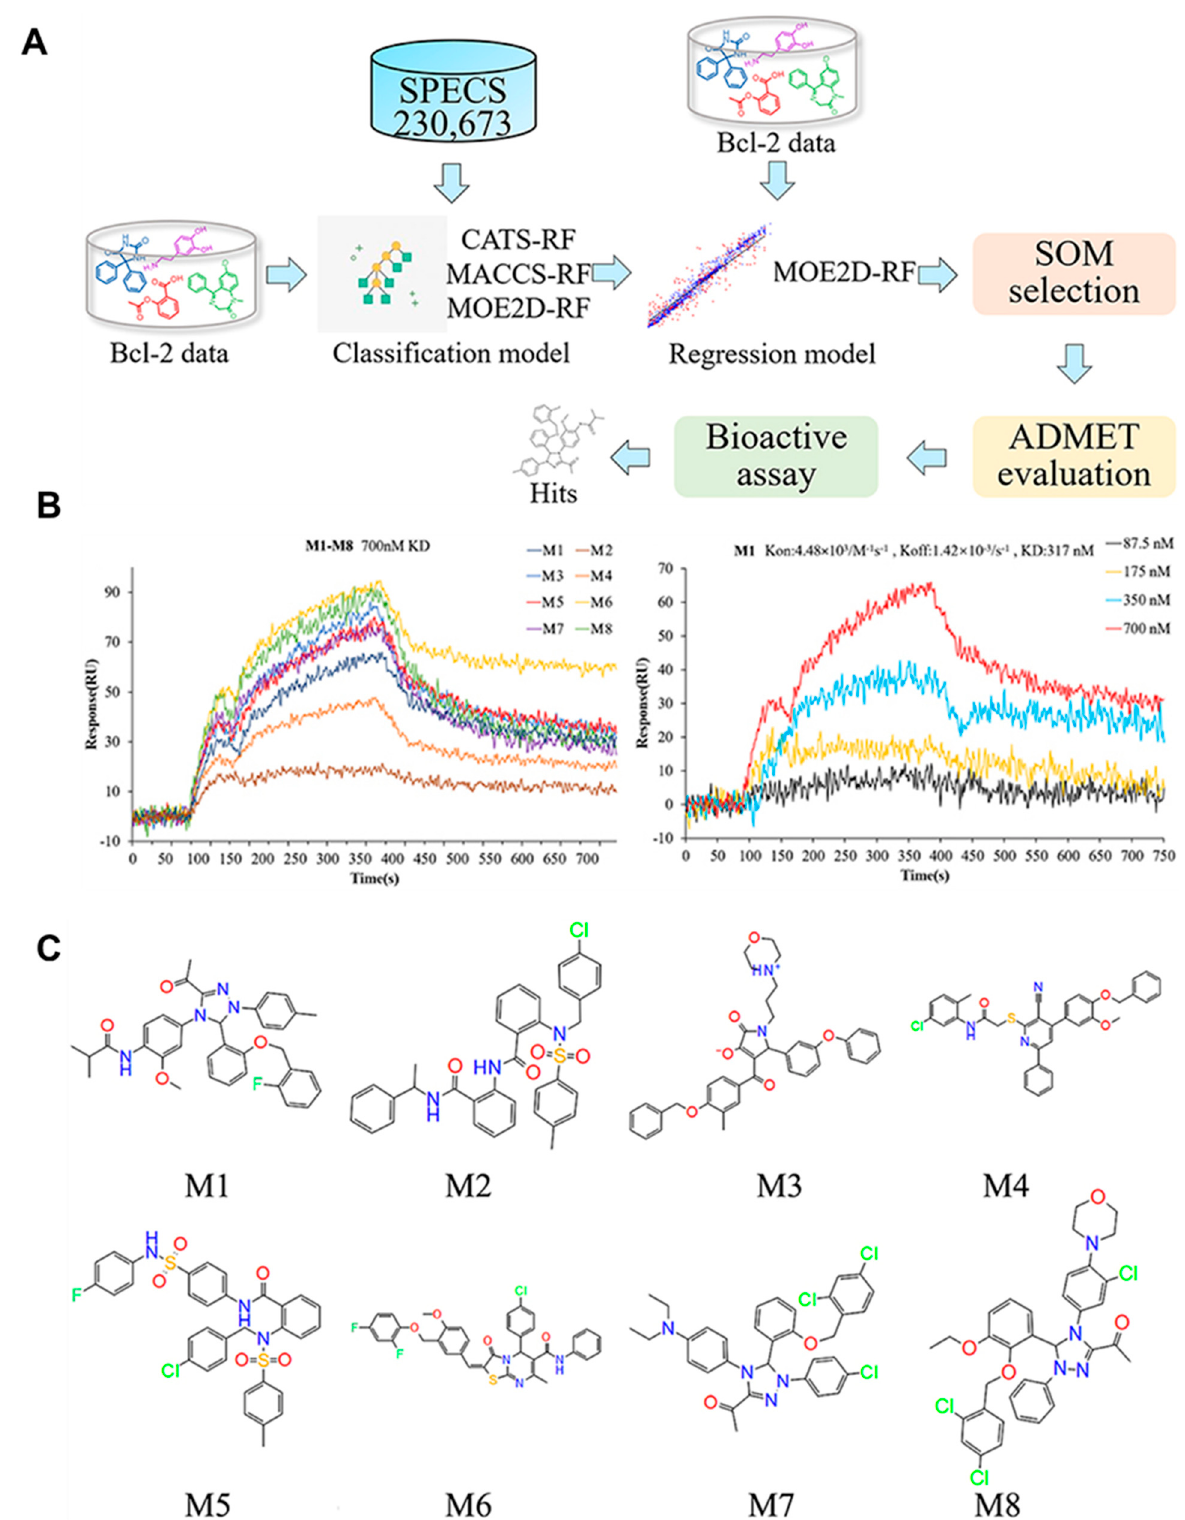
Figure 8. SPR technique was used to investigate the interaction between the potential drug candidates and Bcl-2. ( A ) Colored lines stand for the binding curves for the eight potential drug candidates. ( B ) Four colored lines indicate the binding curves for the various concentration gradients for M1. ( C ) Chemical compositions of the substances M1–M8 [148].